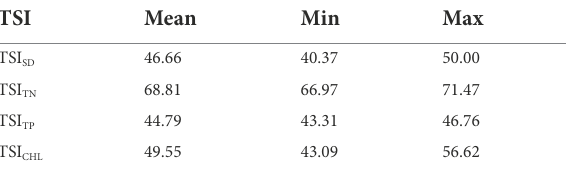
TABLE 1 Summary of Trophic Status Index (TSI) in Wujiangdu